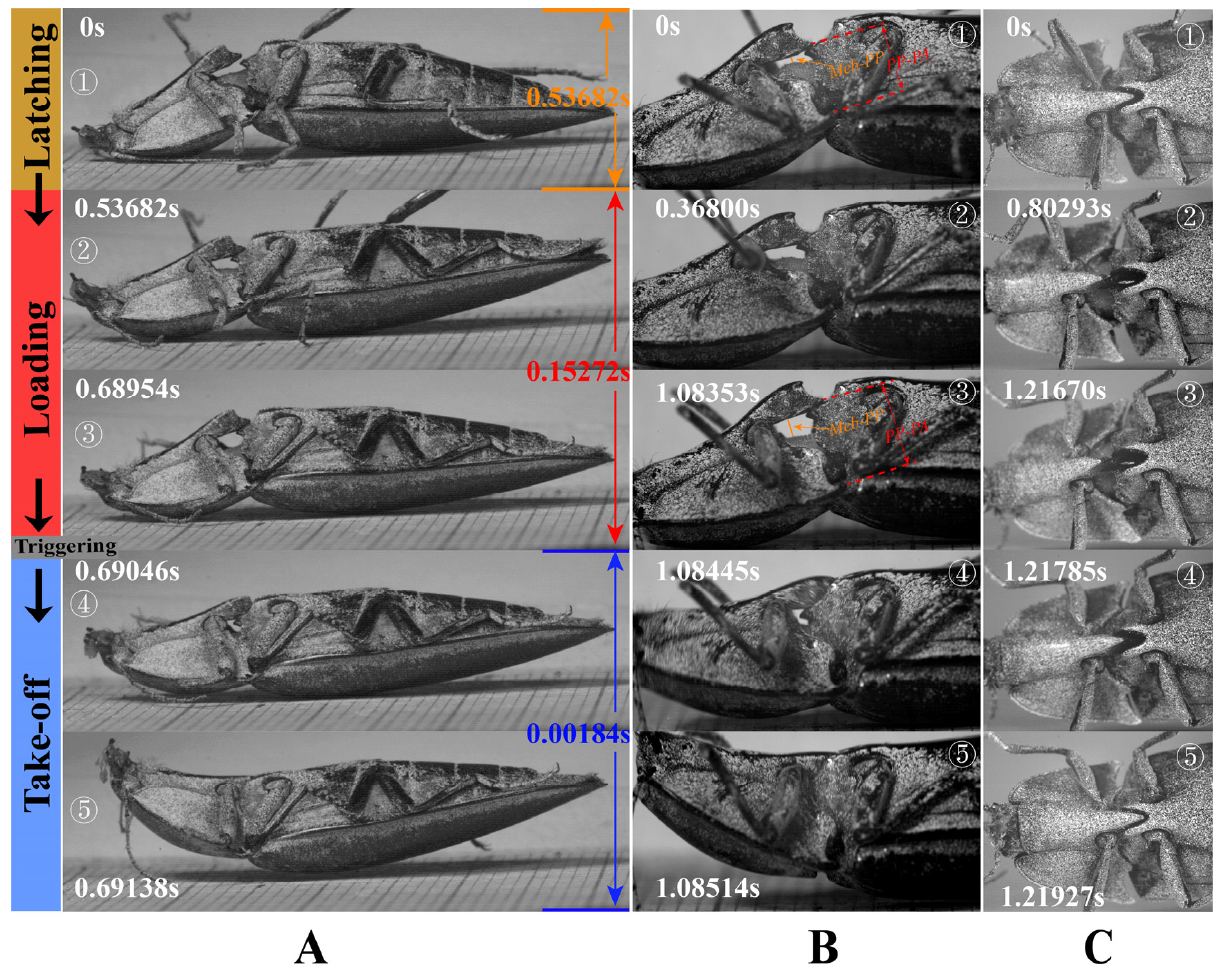
Figure 12. The jumping process of Campsosternus auratus . The airborne phase is not shown. Photos were taken using a high-speed camera at 4347.8 fps (frame interval of 230 µ s) and an exposure time of 50 µ s. The beetles were coated with dye penetrant inspection materials, in order to enhance the quality of high-speed filming. 1 (cid:13) : latching phase; 2 (cid:13) , 3 (cid:13) : loading phase; and 4 (cid:13) , 5 (cid:13) : take-off phase. ( A ) lateral view of the body. ( B ) lateral view of the thorax; PP-PA indicates the distance between dorsal apex of prosternal process (PP) and apex of posterior angle of pronotum (PA), Meb-PP indicates the distance between Meb and ventral surface of PP. ( C ) ventral view of the